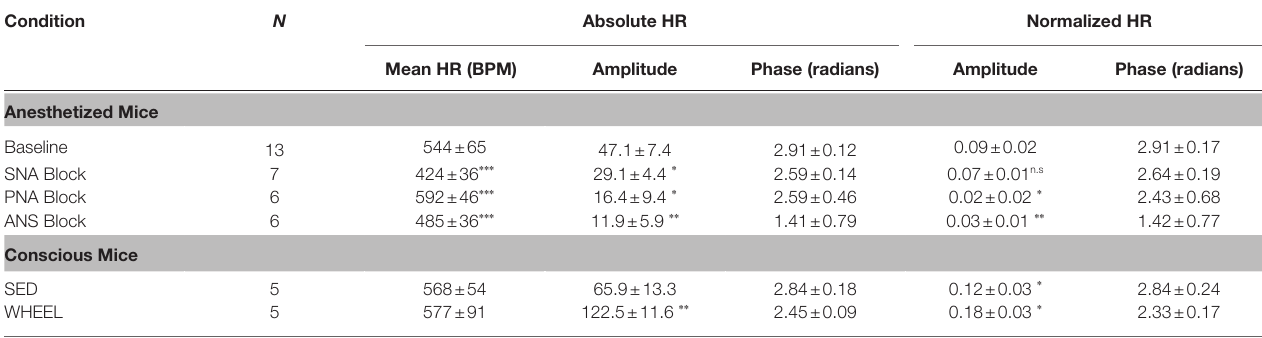
The amplitudes and phase shifts were obtained by nonlinear fits of the HR results to sine functions for various conditions: Baseline = no blockers, SNA Block = with propranolol, PNA Block = with atropine, ANS Block = with atropine and propranolol, SED = conscious mice with no wheel access, and WHEEL = conscious mice with wheel access. Data presented as Mean ± S.D. * p<0.05, ** p<0.01, *** p<0.001, and n.s (P=0.06) compared to baseline or sedentary mice with no wheel access using an extra sum-of-squares F test. Additional within- and between-group comparisons are outlined in the